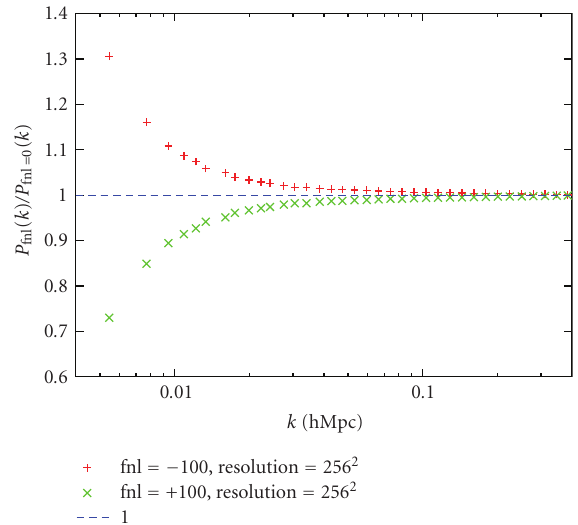
Figure 10: Ratio between the z = 2 Ly α flux power spectrum extracted from simulations of Gaussian and non-Gaussian initial conditions. The mean transmission is set to F = 0 . 8 and the power- law exponent α = 1 . 65 (see